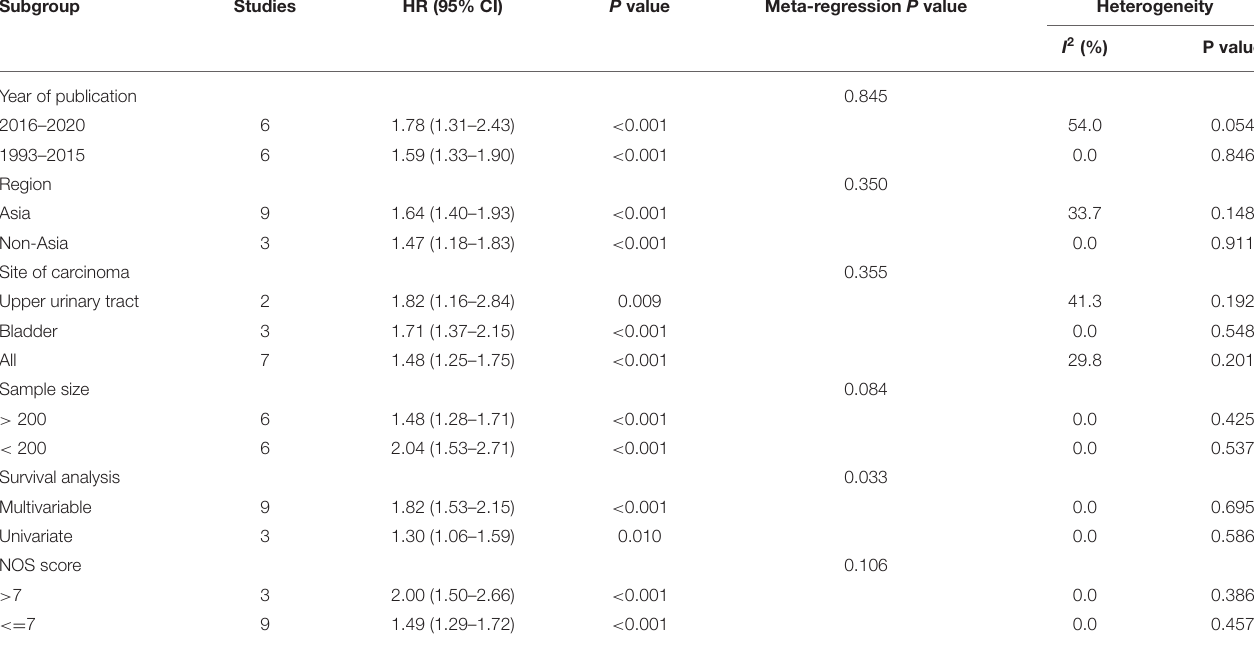
TABLE 4 | Subgroup analyses for overall survival in urothelial carcinoma.